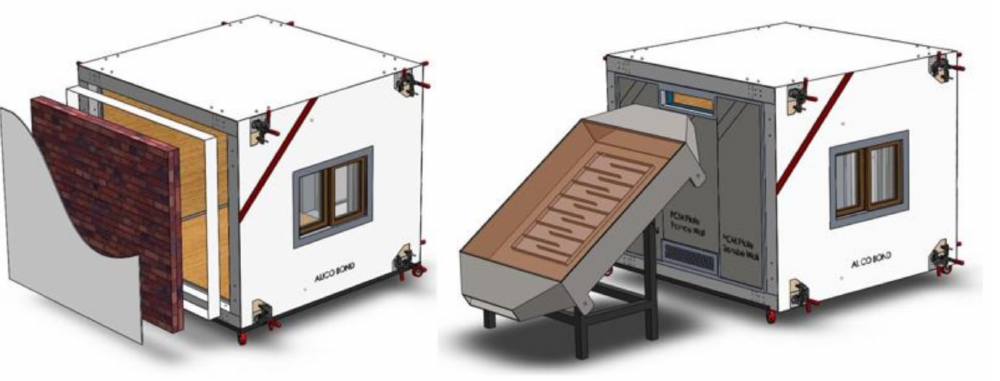
Figure 25. Brick wall sections for application P1 (to the left) and solar air heater installed with necessary edits of the side wall of ThermoGreen ® (to the right).